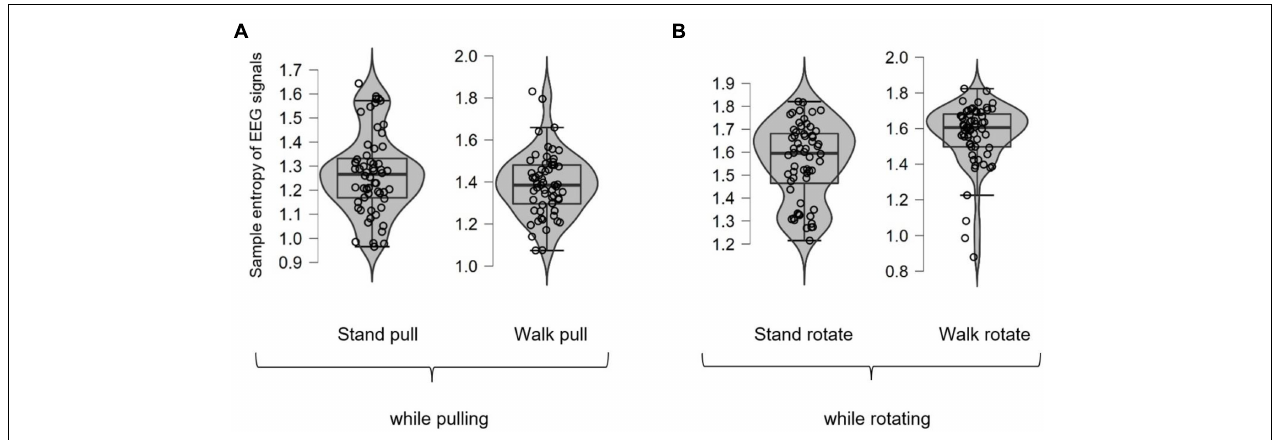
FIGURE 7 | The box plots for the sample entropy of EEG signals in walking and standing while pulling (A) and rotating (B) .